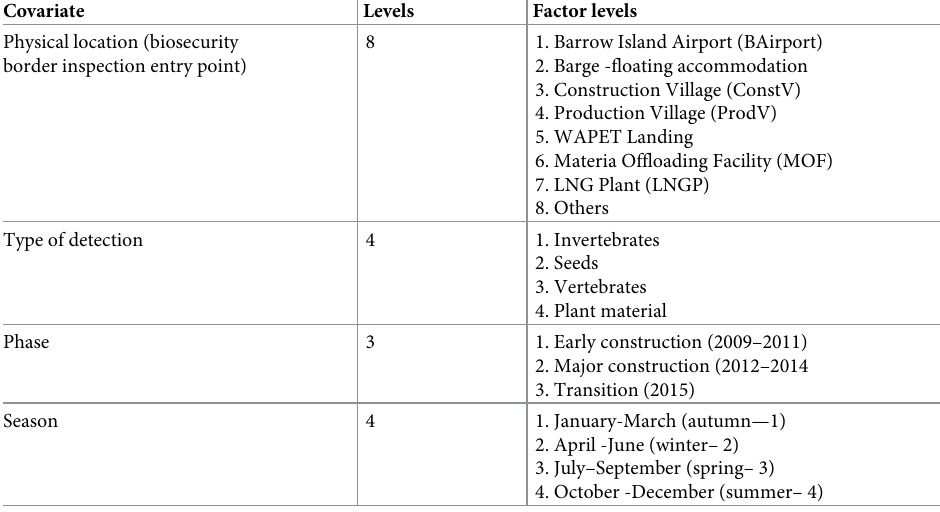
Table 1. Description of covariates used in the cluster model based on biosecurity detections from Barrow Island from 2009 to 2015. Covariate Levels Factor